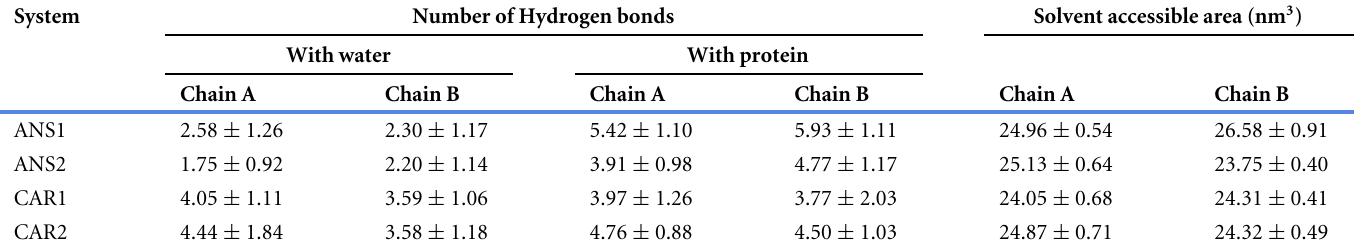
Table 1 Number of hydrogen bonds of each ligand with water and protein and the solvent accessible areas in the active site. The active site is defined by H106, E173, E174, G176, S177, D202, N220, R350, A421, S423, T424, E451, H235B, T335B (T335 from chain B) and T337B (T337 from chain B), respectively (see their location in Figure